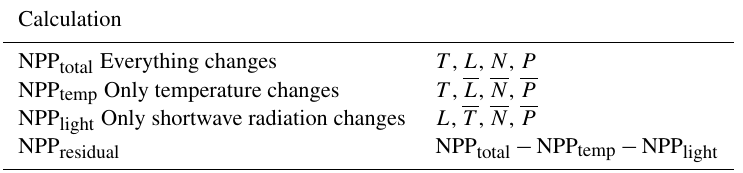
Table 1. Description of the offline calculations of ocean NPP and primary drivers using Eqs. (1)–(3). T is the average temperature in the top 100m, L is shortwave radiation attenuated to 50m of depth, N is the concentration of the limiting nutrient (either nitrate, phosphate, or dissolved iron) in the top 100m, and P is the concentration of phytoplankton cells in the top 100m. X denotes the long-term (80-year) mean of the given variable.